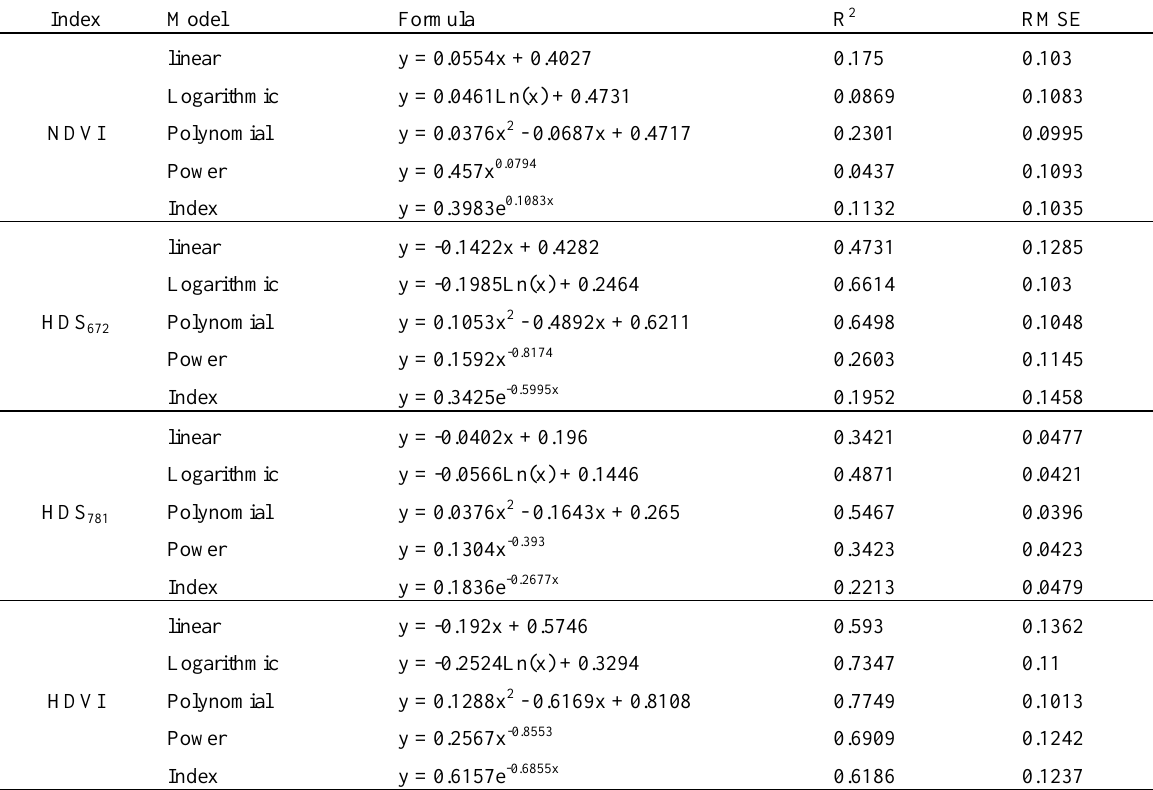
Table 5. The different modes between Indices and LAI using the CHRIS/PROBA data